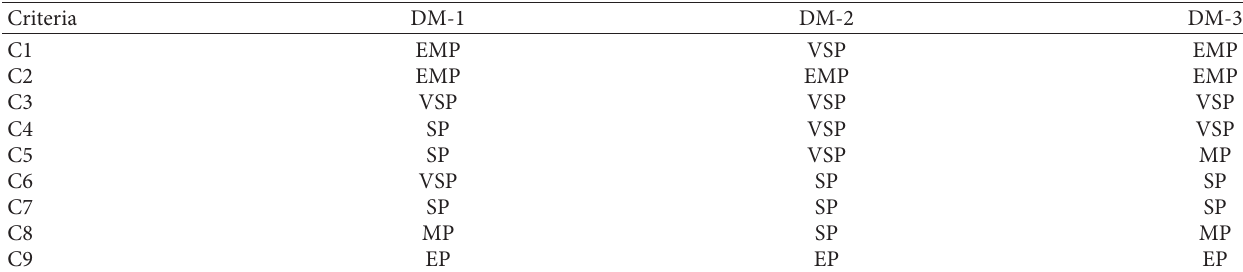
Table 6: Decision-makers’ linguistic preferences for all other criteria with regard to the worst criterion (others-to-worst vector). Criteria